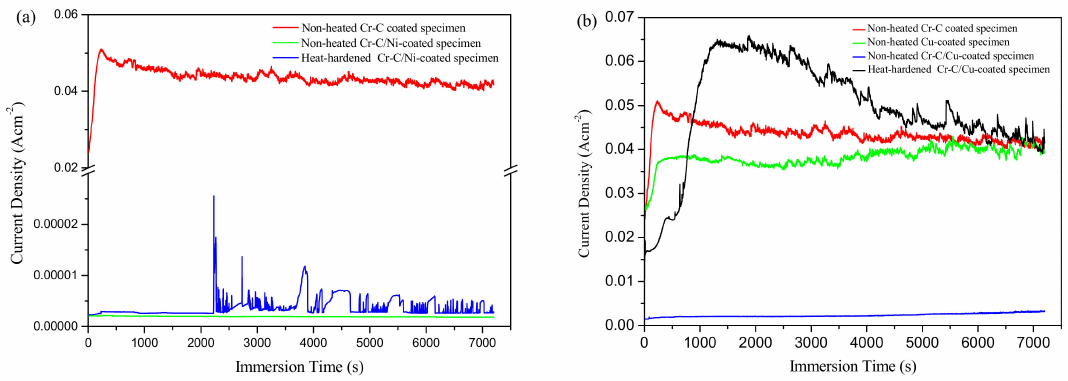
Figure 7. Variation of anodic current density during potentiostatic etching at 0.5 V by using Cr–C-coated samples with ( a ) Ni- and ( b )